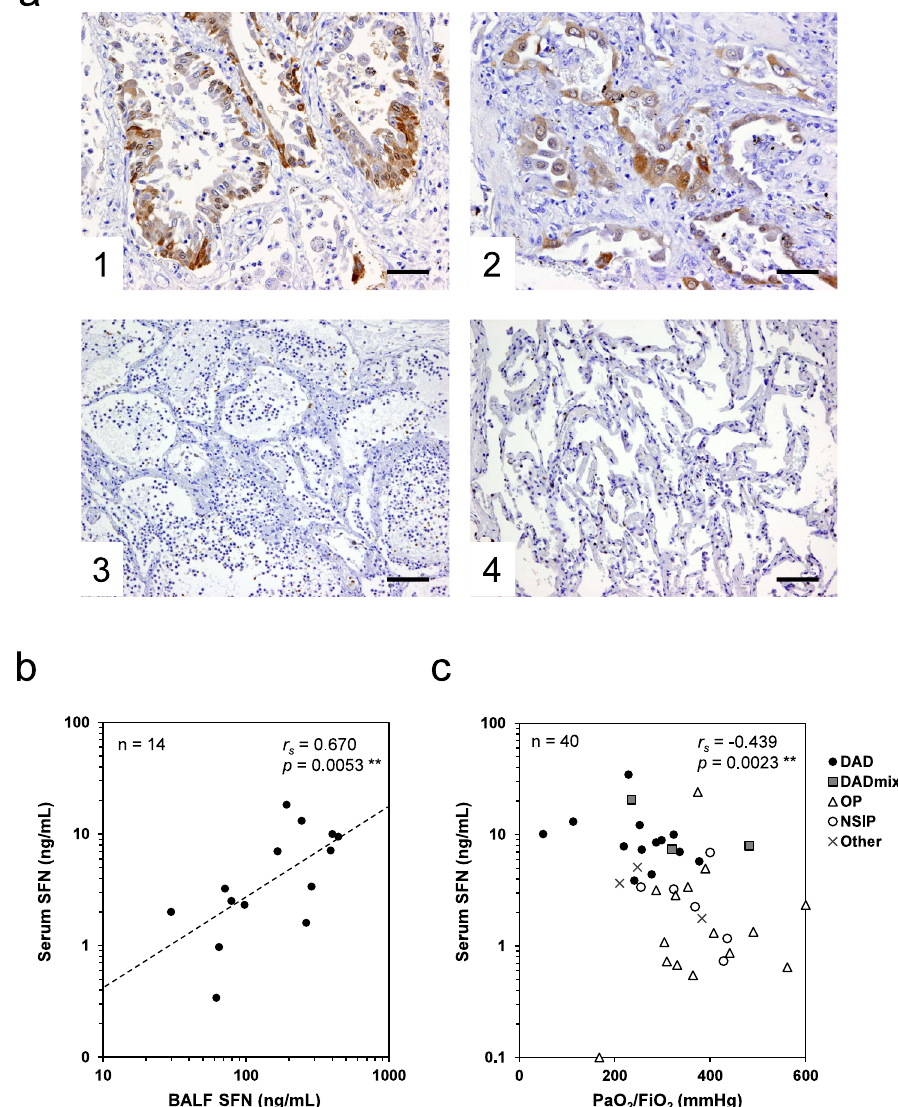
Fig.5|SFNexpressioninlungtissue,andassociationsofserumSFNlevelswith those in BALF and with pulmonary functions. a Representative immunohisto- chemicalstainingforSFN.Clearexpressionwasobservedinthebasalcellsofthe bronchioles ( a1 , 200×) and alveolar type II cells ( a2 , 200×) in DAD specimens. Positive staining was not observed in the cells of alveolitis with bleeding in lung cancer patients ( a3 , 100×) and normal-looking lung tissue ( a4 , 100×). Scale bars are 50 μ m ( a1 , a2 ) and 100 μ m ( a3 , a4 ). b Correlation between serum SFN and